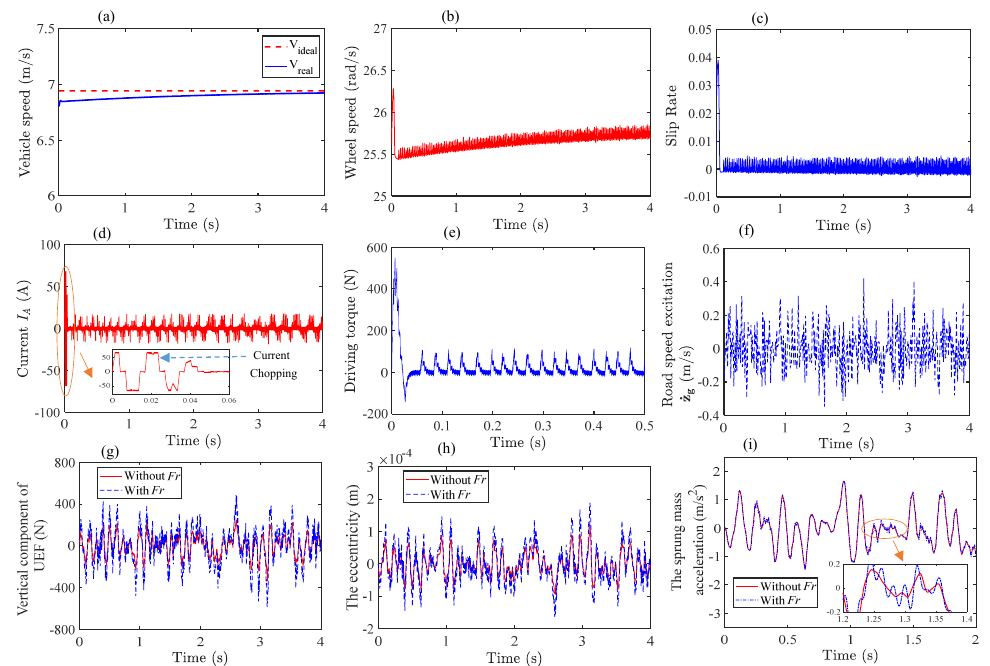
Figure 5. The response of the electric vehicle on stochastic uneven road: ( a ) vehicle speed; ( b ) wheel speed; ( c ) slip rate; ( d ) A-phase current; ( e ) driving torque; ( f ) road speed excitation; ( g ) vertical component of the UEF; ( h ) the rotor eccentricity; ( i ) the sprung mass acceleration.